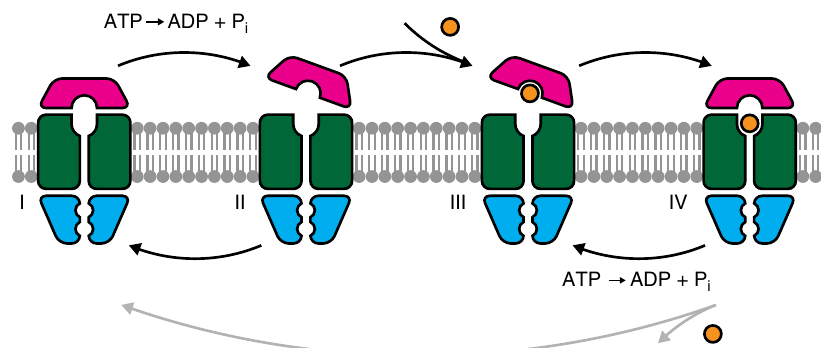
Fig. 5 Transport model. BtuCD-F forms a stable complex in the ground state (I, corresponding to PDB ID 2QI9 and 4DBL). Binding and hydrolysis of ATP partially dislodges BtuF from the transporter (II, related to PDB ID 1L7V and 4R9U). In the absence of vitamin B 12 , the complex cycles back and forth between states I and II. When substrate is present, BtuF can catch it (III), and the complex will fully associate capturing the vitamin inside the complex (IV, corresponding to PDB ID 4FI3). From this state, the transporter can either translocate the substrate molecule and return to the ground state (I), or it can return via ATP binding and hydrolysis back to the previous state (III). The latter pathway, which does not transport any molecule, is more likely